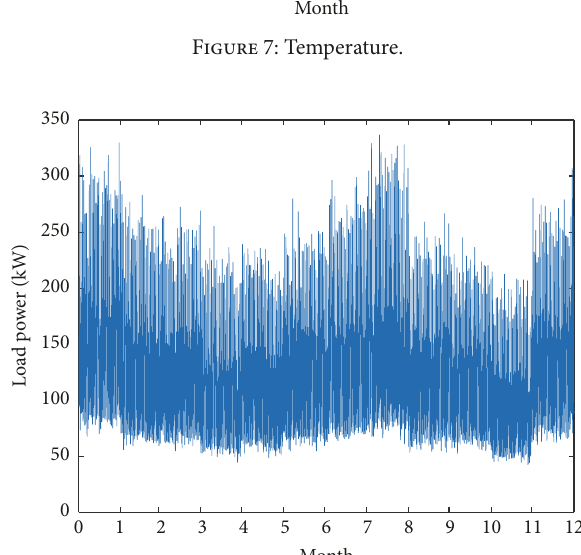
Figure 7: Temperature.